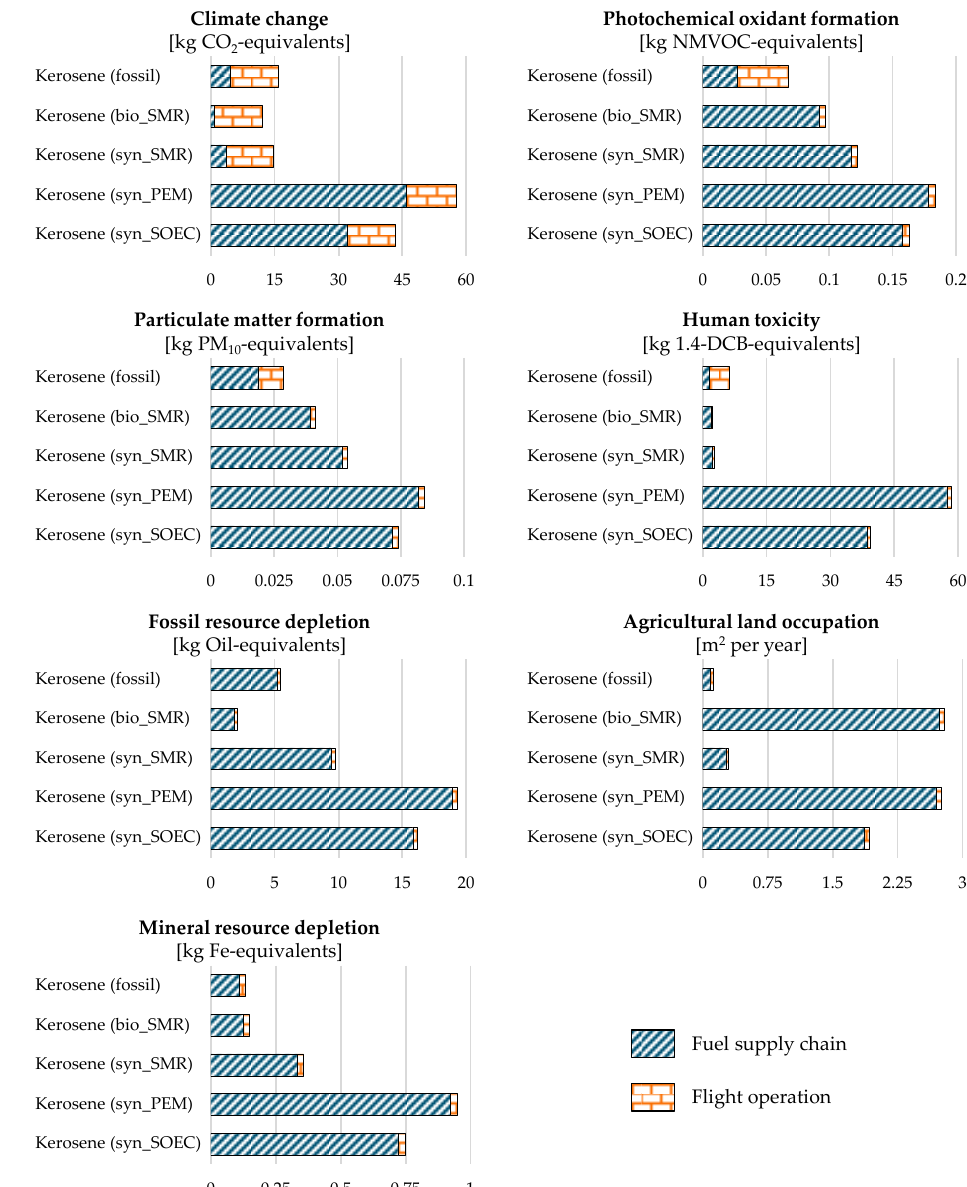
Figure 4. Comparison of environmental impacts per 100 pkm for SAFs and fossil kerosene and a breakdown of the impact scores regarding the fuel supply chain and flight operation.